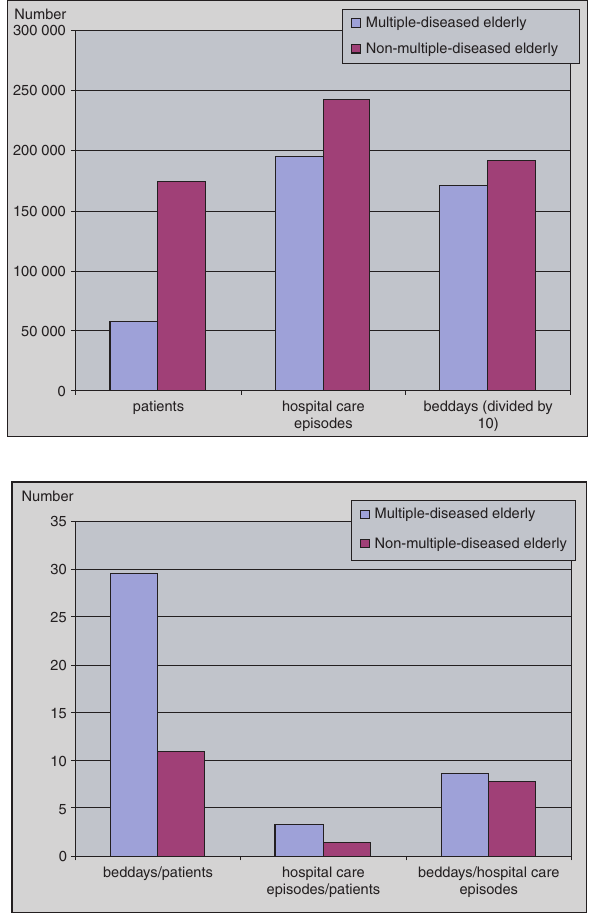
Figure 1. Comparison of the annual hospital care consumption of the multiple-diseased elderly patients with that of 75 years old or older patients, not defined as multiple-diseased